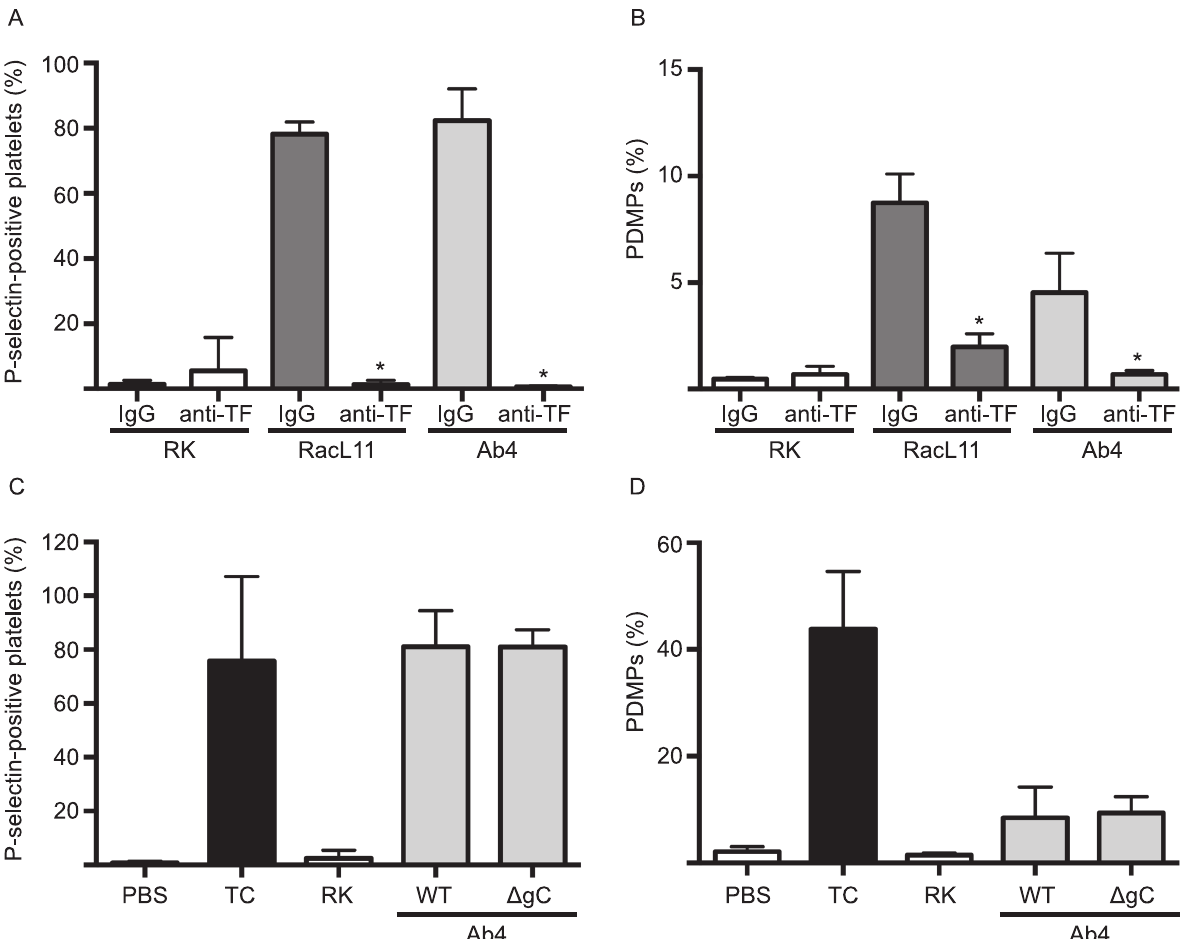
Fig 6. Tissue factor mediates EHV-1-induced platelet activation, with no role for virus glycoprotein C. A goat polyclonal anti-rabbit tissue factor (TF) antibody (anti-TF, 152 ug/mL) abolished P-selectin expression ( A ) and significantly decreased the numbers of platelet-derived microparticles (PDMP) ( B ) in equine platelets exposed to RacL11 and Ab4 EHV-1 strains at 1 PFU/cell (n = 6). Data shown is mean ± SD. � p < 0.001 for P-selectin and p = 0.025 for PDMPs versus goat IgG controls. In contrast, platelets still expressed P-selectin ( C ) and shed PDMPs ( D ) when exposed to an Ab4-based envelope glycoprotein C deletion mutant ( Δ gC) at 1 PFU/cell (n = 8). Data shown is mean ± SD.